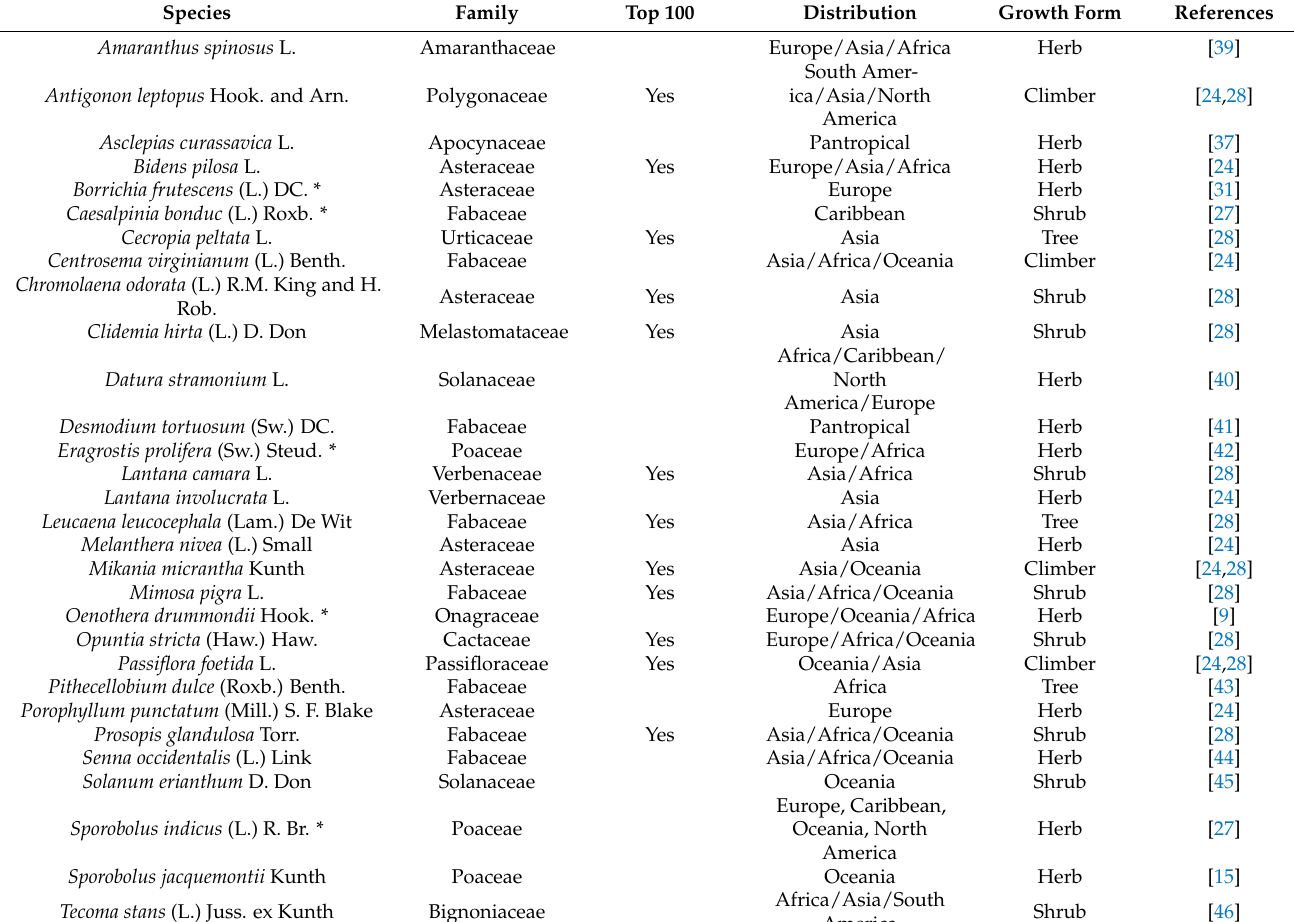
Table 4. List of plant species native to Mexico, found on coastal dunes, and considered invasive abroad. Top 100 from GISD [28] * Species typical of Mexican coastal